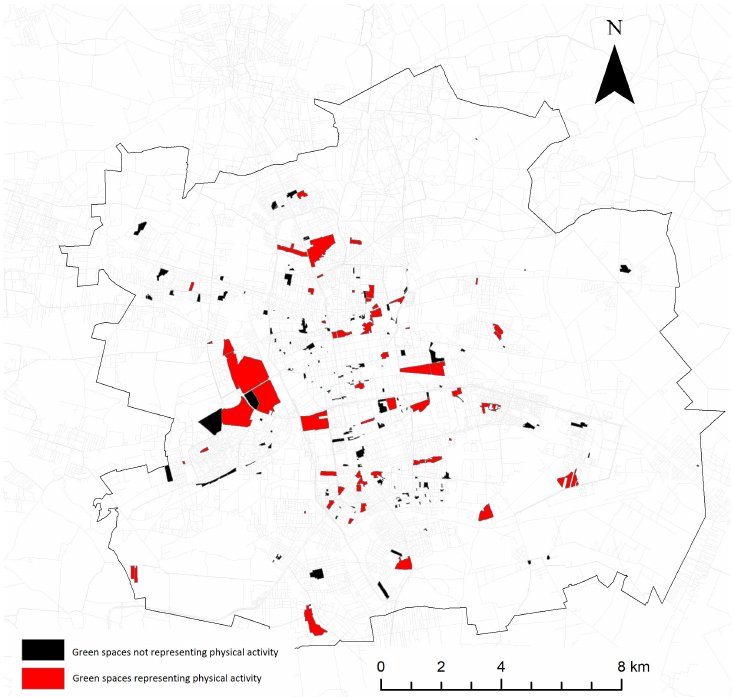
Figure 2. Urban green spaces in Lodz representing the “physical activity” sociotope category.